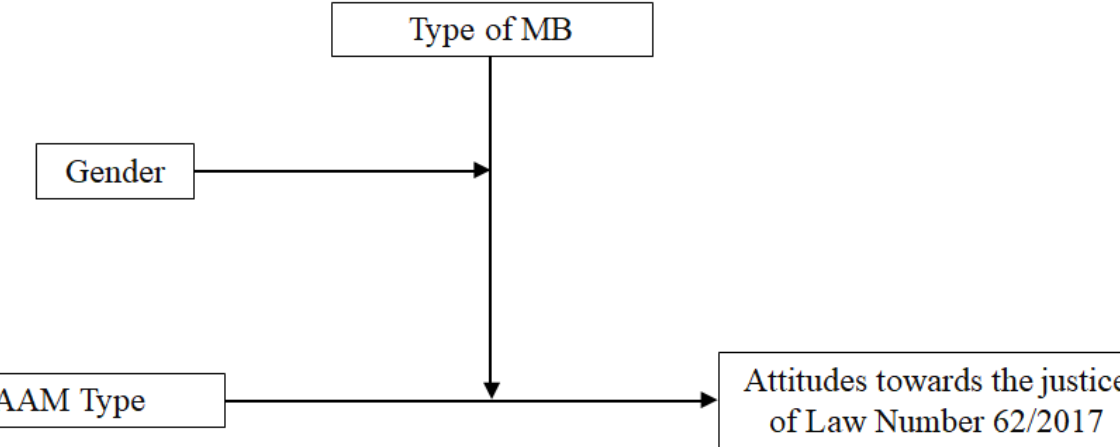
Figure 1. Research model proposed. MB—Meritocracy Beliefs; AAM—Affirmative Action Measure